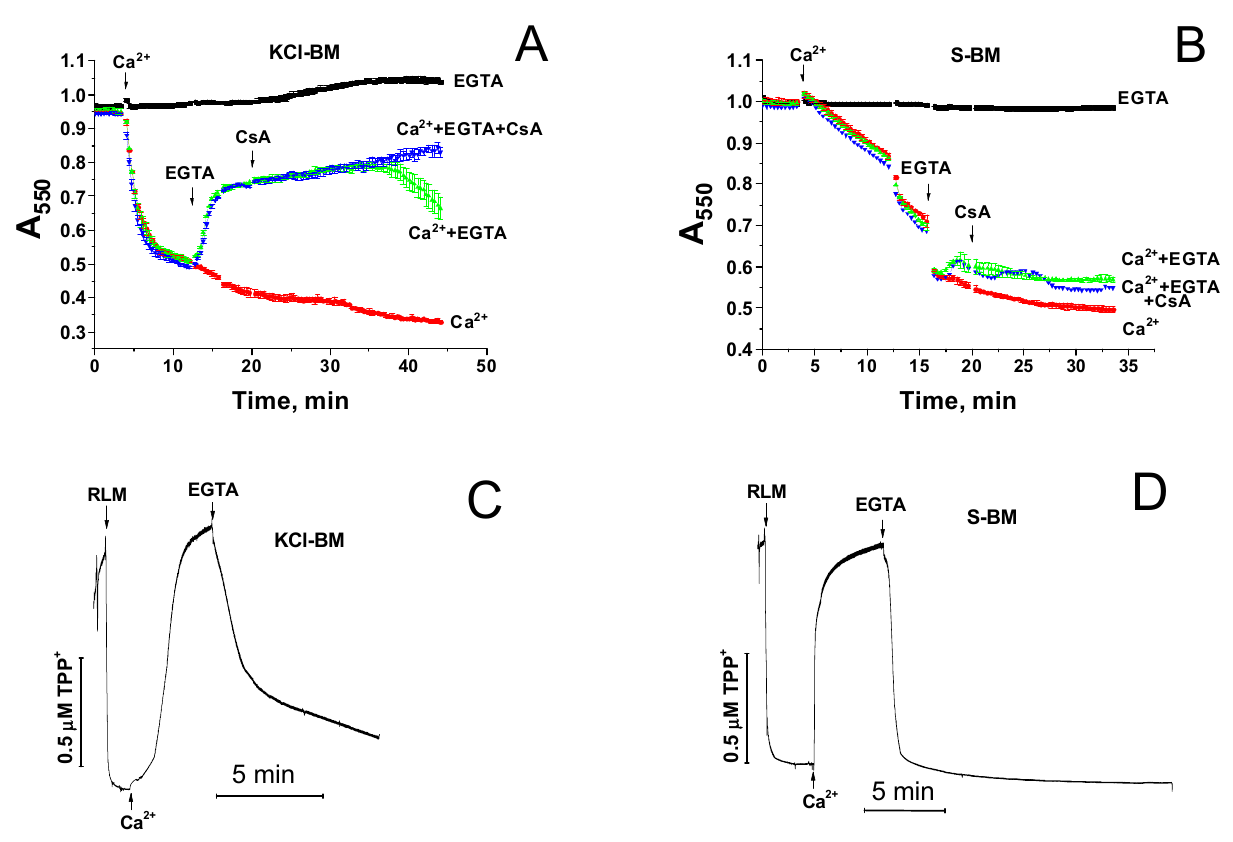
Figure 3. Effect of EGTA- and CsA-induced mPTP closure on the mitochondrial shrinkage ( A , B ) and ∆Ψ m recovery ( C , D ) in KCl-BM and S-BM. A and B. Just before measurements, RLM (0.75 mg prot./mL) were added to KCl-BM ( A ) or S-BM ( B ) supplemented, where indicated, with 1 mM EGTA. Arrows show the addition of 100 µ M Ca 2+ , 1 mM EGTA, and 1 µ M CsA. ( C , D ). Prior to the measurements, 1.5 µ M TPP + was added to KCl-BM ( C ) or S-BM ( D ). Arrows show the addition of RLM (1 mg prot./mL), 100 ( C ) and 400 µ M Ca 2+ ( D ), and 1 mM EGTA. Representative curves of one experiment of at least three similar are shown.